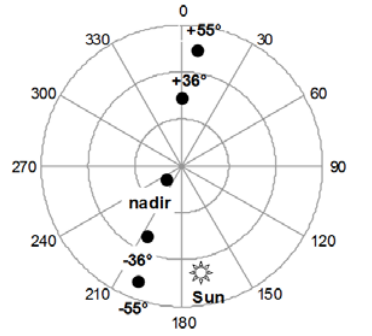
Figure 2. Polar plot showing the actual positions of the five angular CHRIS images during acquisition on 6 September 2005. The solar zenith angle was 46°, the solar azimuth angle